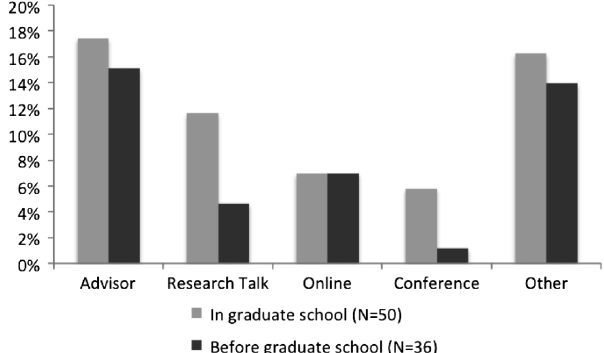
population).FIG. 2. How students found out about PER (values are the percentage of the total